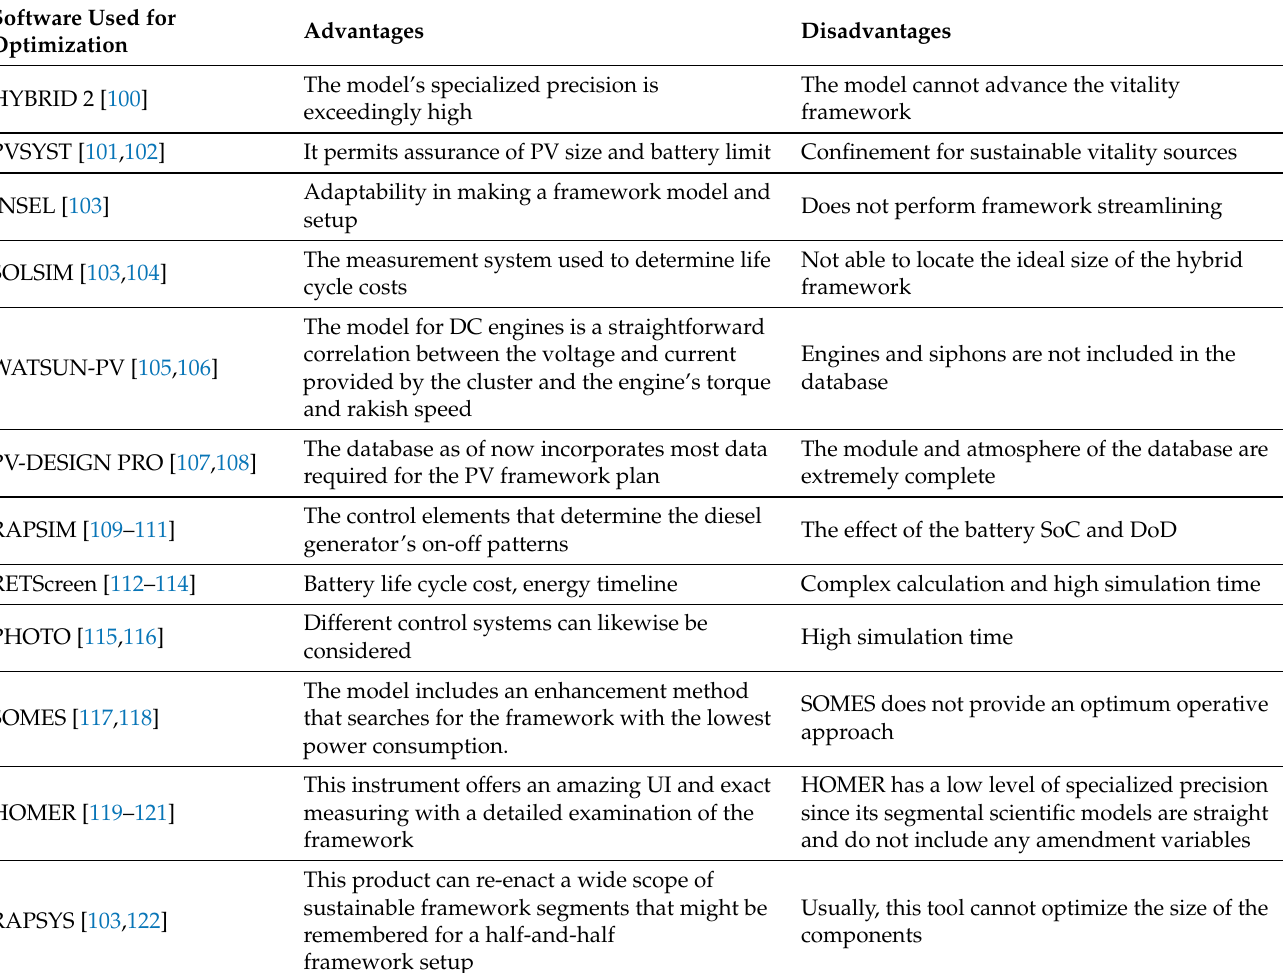
Table 4. Various types of software tools for the optimization of the hybrid